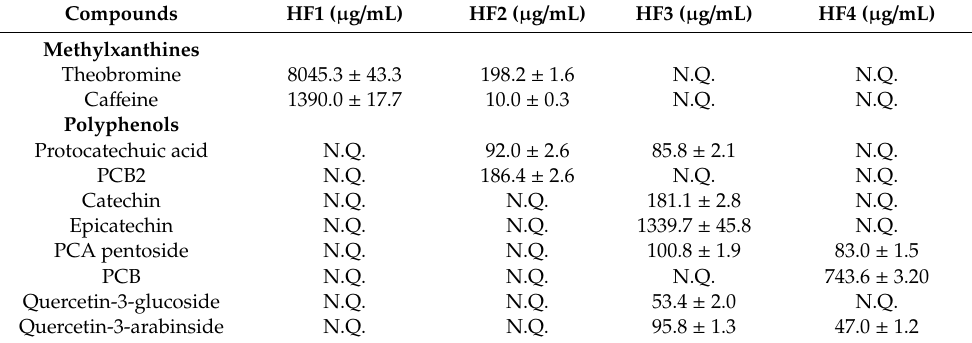
Table 1. Main composition of HFs.